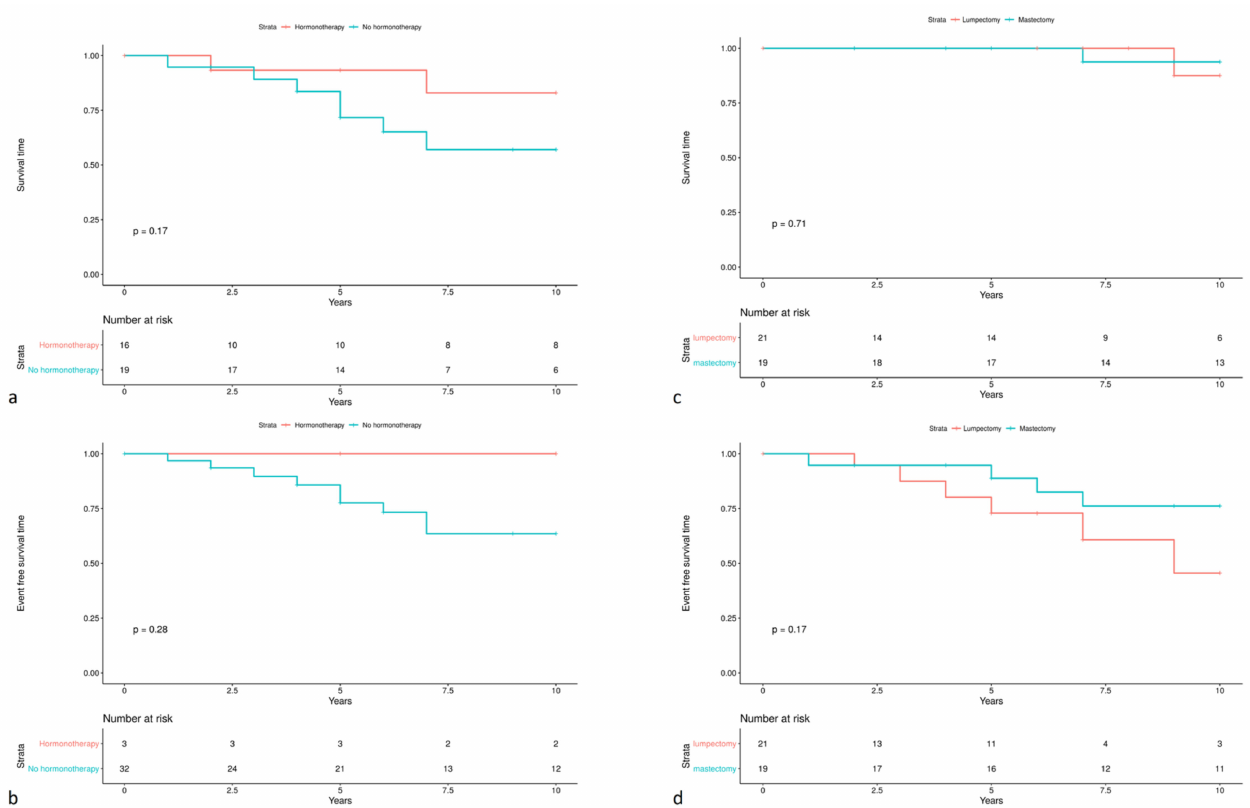
Figure 3. Kaplan-Meier Curves of 10-Year Survival among female patients with ER-positive breast cancer diagnoses, carrying a CHEK2 pathogenic variant. ( a ) Overall survival defined by administration of hormone-therapy. ( b ) Event-free survival defined by administration of hormone-therapy. ( c ) Overall survival defined by type of breast surgery. ( d ) Event-free survival defined by type of breast